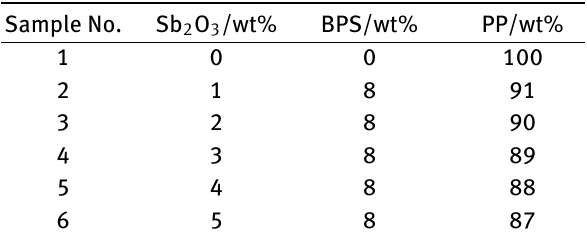
Table 1: The compositions of the experimental materials (mass fraction) Sample